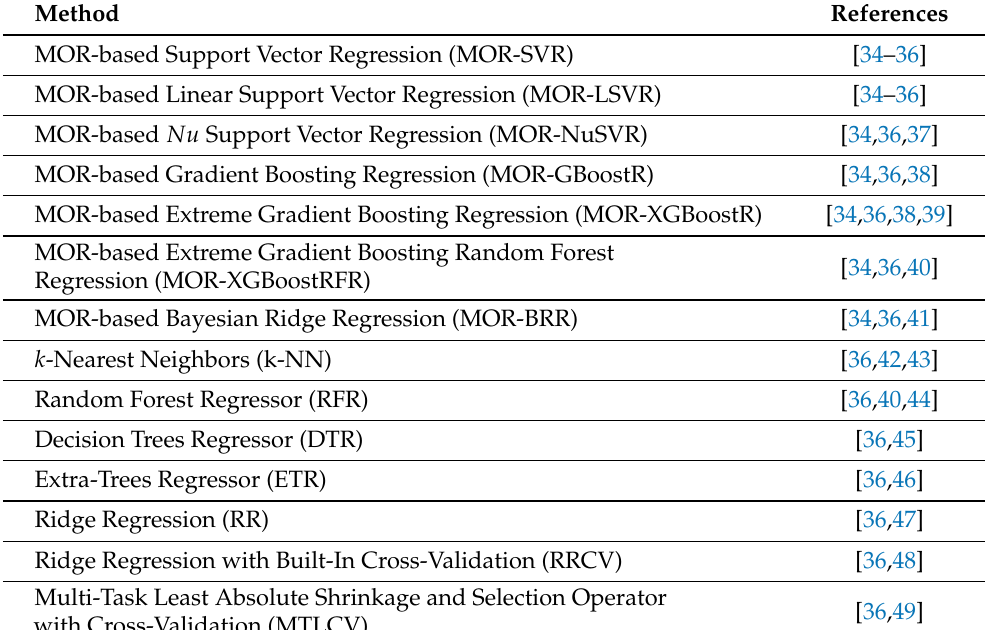
Table 3. The regression learning methods investigated.